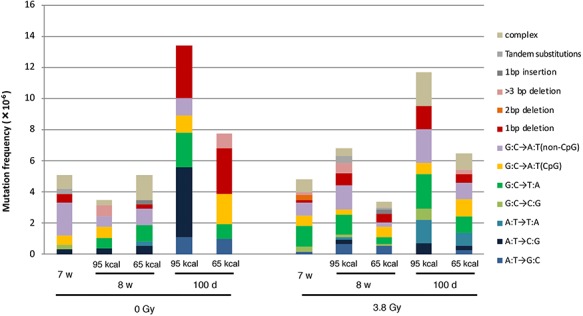
Frequencies of each kind of mutations identified in the gpt gene in the spleen of gpt delta mice. The data on frequencies of each type of mutation in Table 2 are presented.